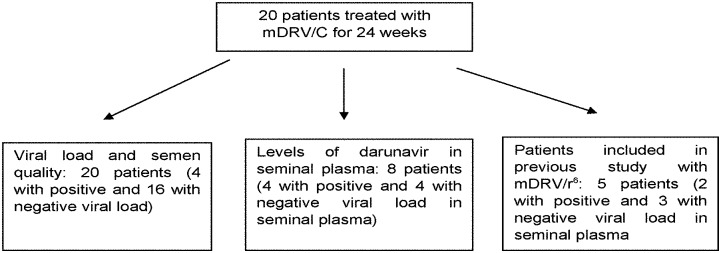
Patients included in different procedures of the study according to the seminal viral load.